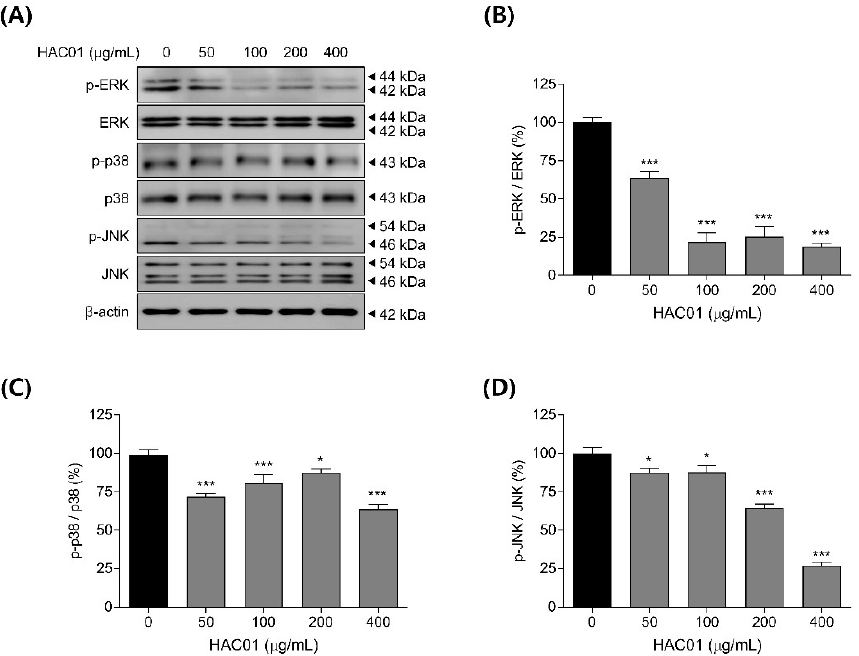
Figure 8. Effects of Lactobacillus plantarum HAC01 lysate on MAPK inhibition in 3T3-L1 cells. Adipocyte differentiation was induced in the presence of L. plantarum HAC01 lysate for 2 d. ( A ) Western blotting band images of MAPK signaling components. Representative bands from triplicate experiments are shown. ( B – D ) Relative protein expression levels of ( B ) p -ERK/ERK, ( C ) p -p38/p38, and ( D ) p -JNK/JNK quantified using Western blotting. ERK, extracellular regulated kinase; JNK, c-Jun N-terminal kinase. All results are presented as mean ± SD. * p < 0.01 and *** p < 0.001 vs. 0 μg/mL.